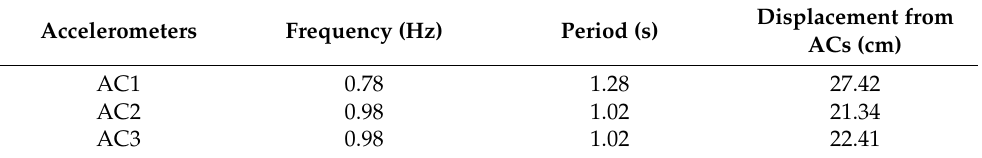
Table 11. Dynamic properties of the IBS frame for test 2.